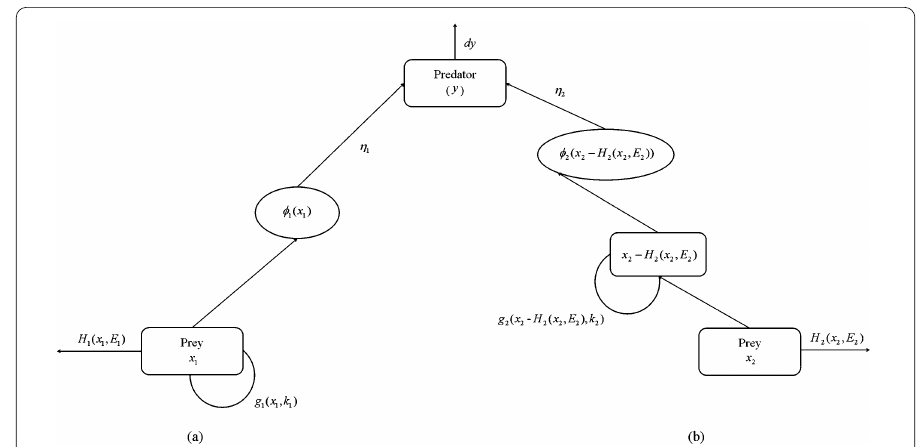
Figure 1 The sketch map of the two forms of harvesting functions. ( a ) A harvested predator–prey model with traditional form of harvesting function. ( b ) A harvested predator–prey model with a new form of harvesting function, where φ 1 and φ 2 denote the predator response function of two prey species, respectively. η 1 and η 2 are the rate of conversion of prey. g 1 and g 2 are the growth pattern of two prey species. m is the per capita death rate of